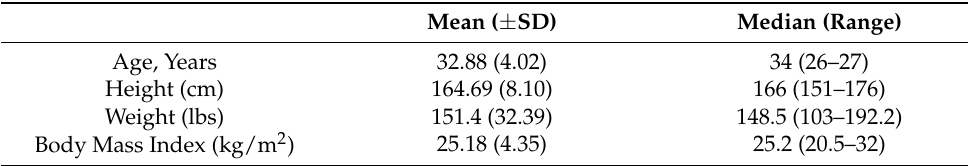
Table 4. Demographic summary of all participants ( n =